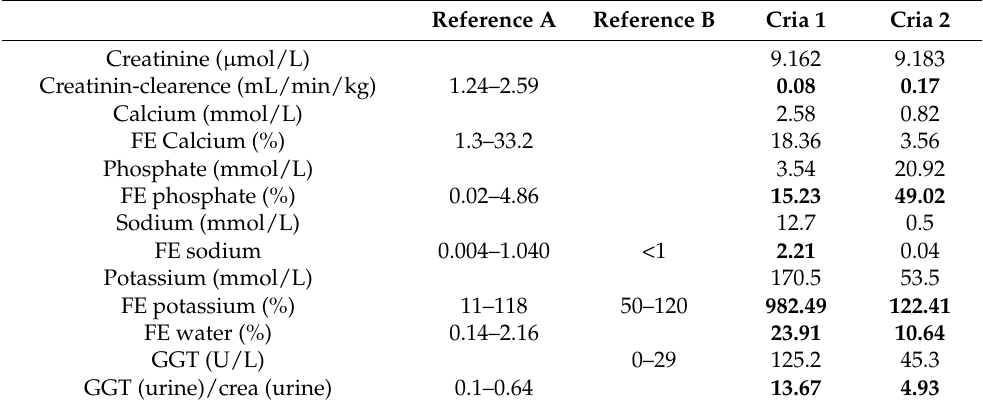
Table 5. Kidney function analysis. Urine values and fractional excretions (FE). Cria 1, day 15 after vitamin D3 injection; Cria 2, day 16 after vitamin D3 injection. Reference values A had been evaluated for horses [30] and not for alpacas; reference values B derive from [36] and are for llamas. Values that differ from the references are displayed in bold. GGT, γ -glutamyltransferase.